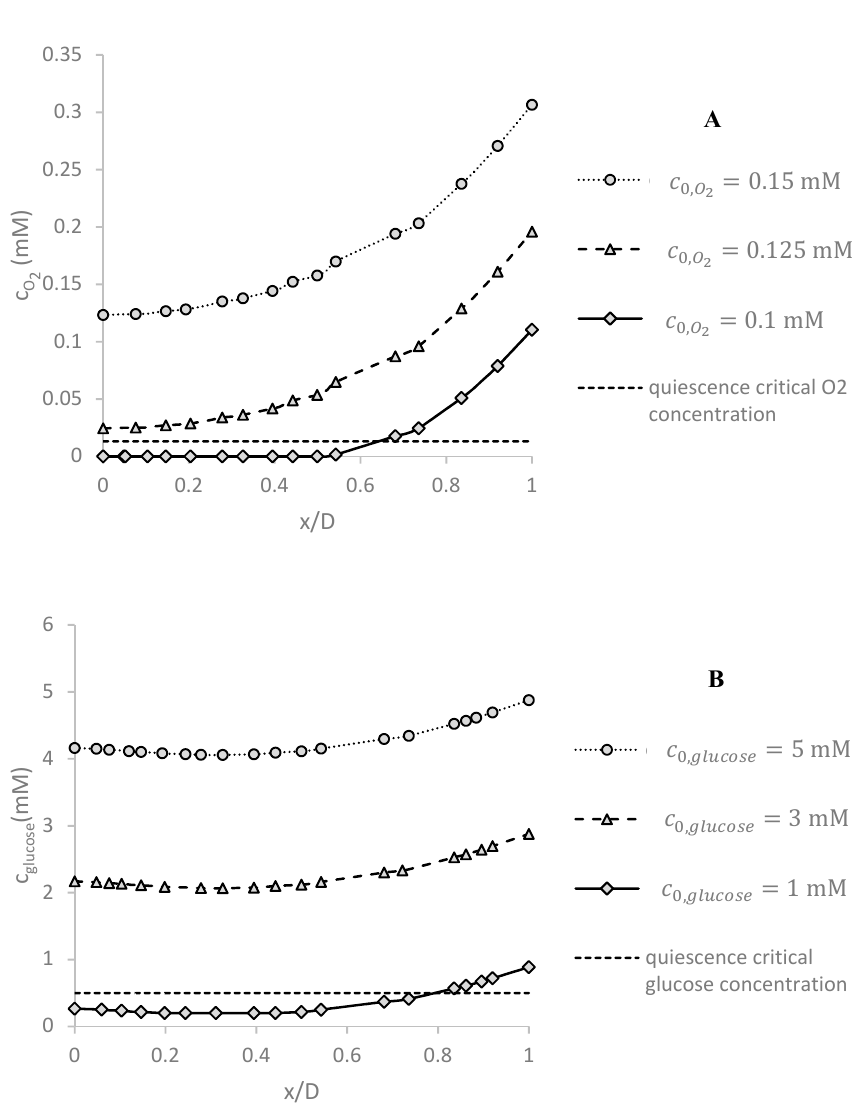
Figure 7. The effect of inlet concentrations of glucose ( c 0, glucose ) and oxygen ( c 0, O 2 on ( A ) glucose and ( B ) oxygen concentration profile in the center of spheroid along x -axis (based on the dimensionless x position: x / D ), respectively. Hypoxia or quiescence is defined when oxygen or glucose concentration is less than the critical value of c O 2 = 0.01322 mM and c = 0.5 mM . If the inlet concentrations of glucose and oxygen are equal or less than 1 mM and 0.1 mM, respectively, some regions of the spheroid are in necrosis and hypoxic conditions. The simulations were done for Q = 5 μ L/min and D = 500 μ m.